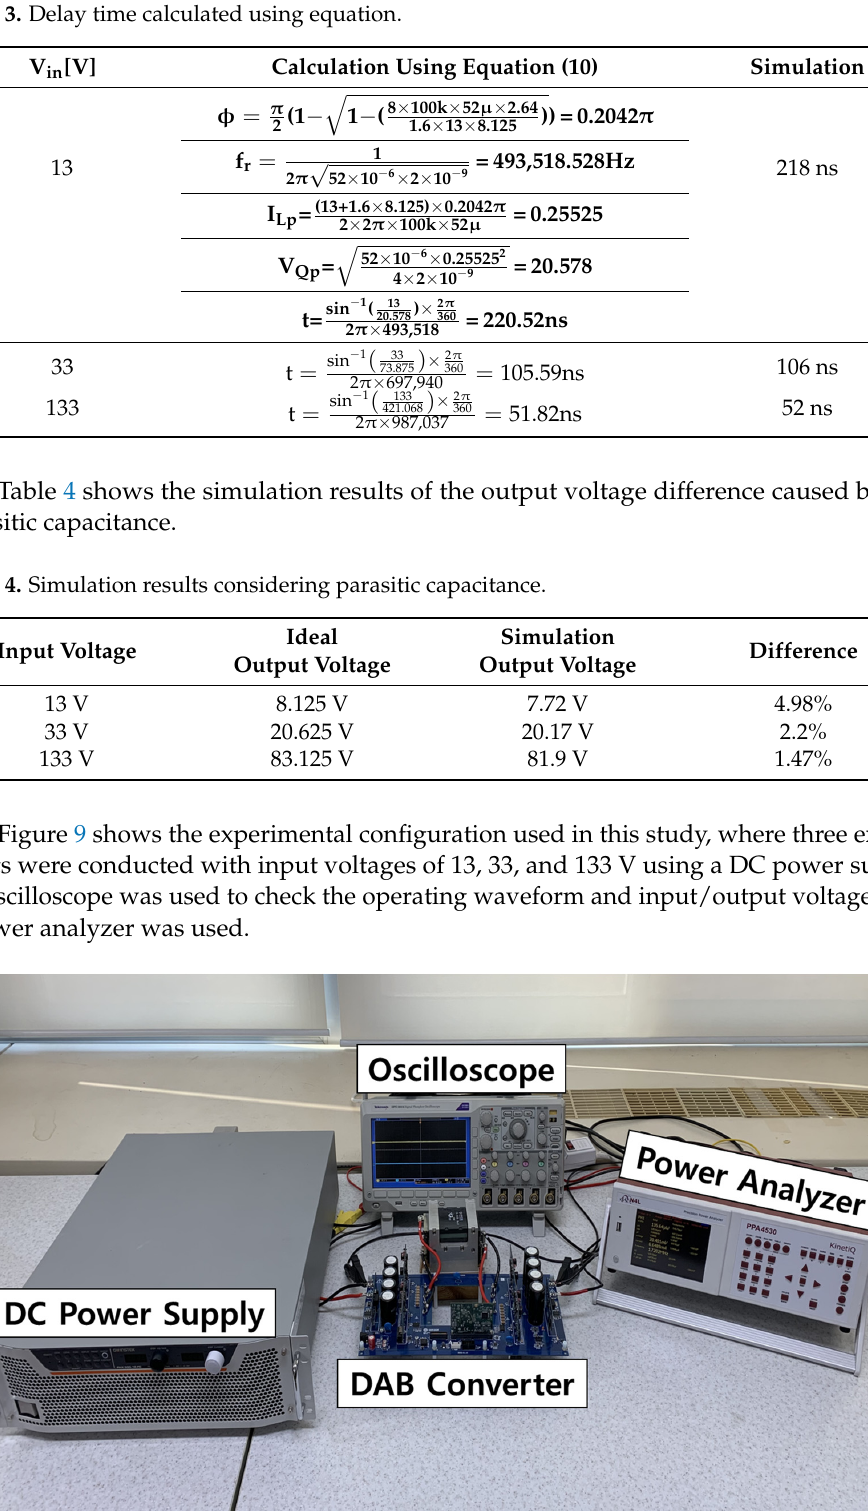
Table 3. Delay time calculated using equation.